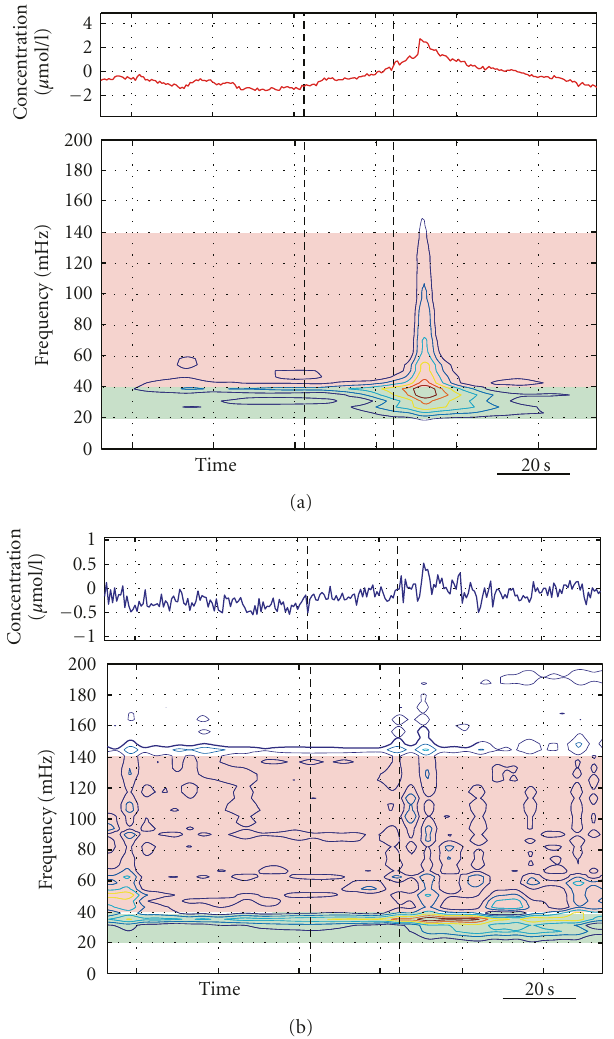
Figure 5: Time-frequency representations of O 2 Hb (a) and HHb (b) concentration signals during BH. The graphs are relative to a subject su ff ering from migraine with aura. The vertical dashed lines mark the BH onset and o ff set. The red rectangle indicates the LF band (40–140 mHz), the green the VLF band (20–40mHz). It is possible to notice that BH seems to neatly increase the LF band power of the signals.